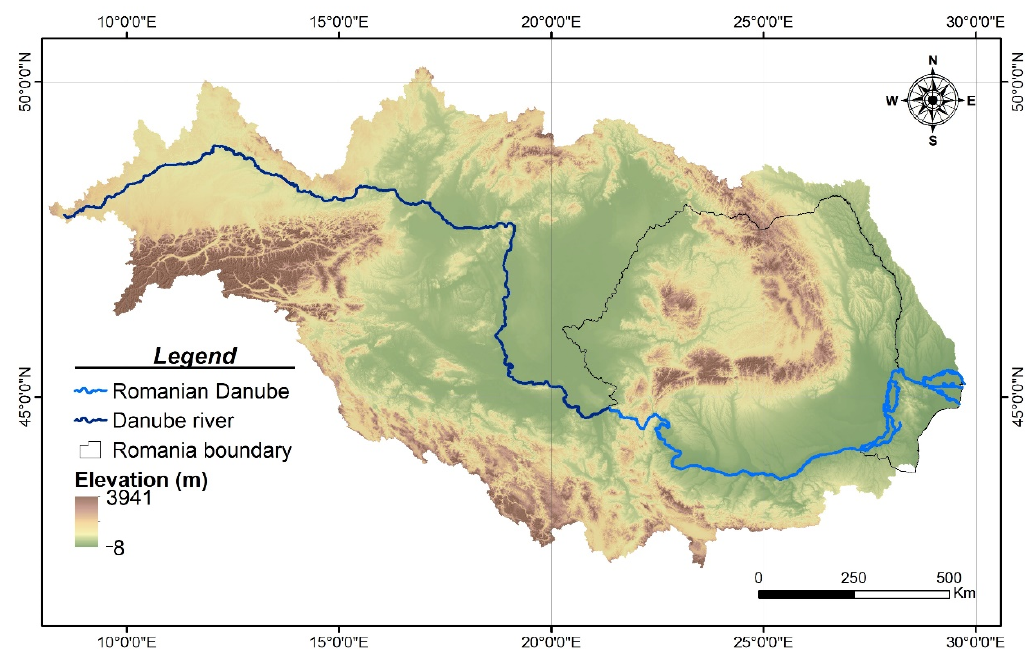
Figure 1. The Romanian Danube in the Danube river basin.